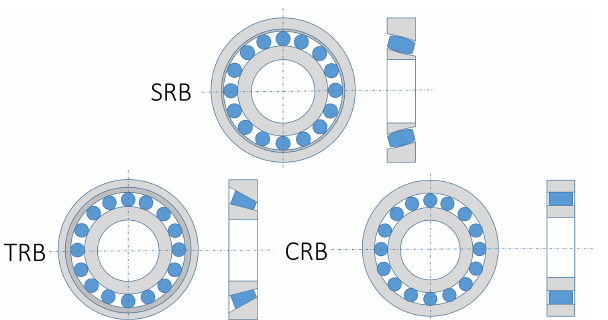
Figure 9. Bearing rolling element types. A single row only is shown for each. Note that for SRBs and TRBs, in WTMB applications, a double-row back-to-back configuration will generally be used on the rotor